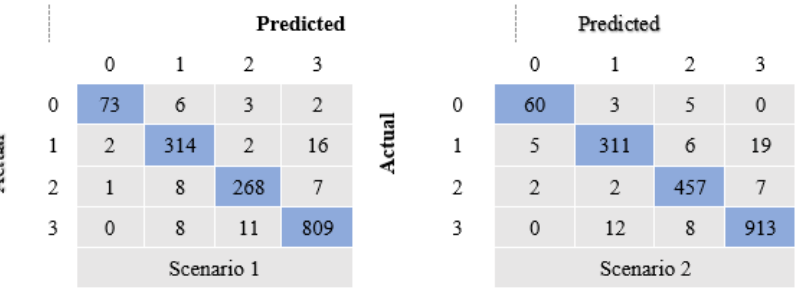
Figure 5. Confusion matrix based on FKTNET-11 model for scenario 1 and scenario 2.